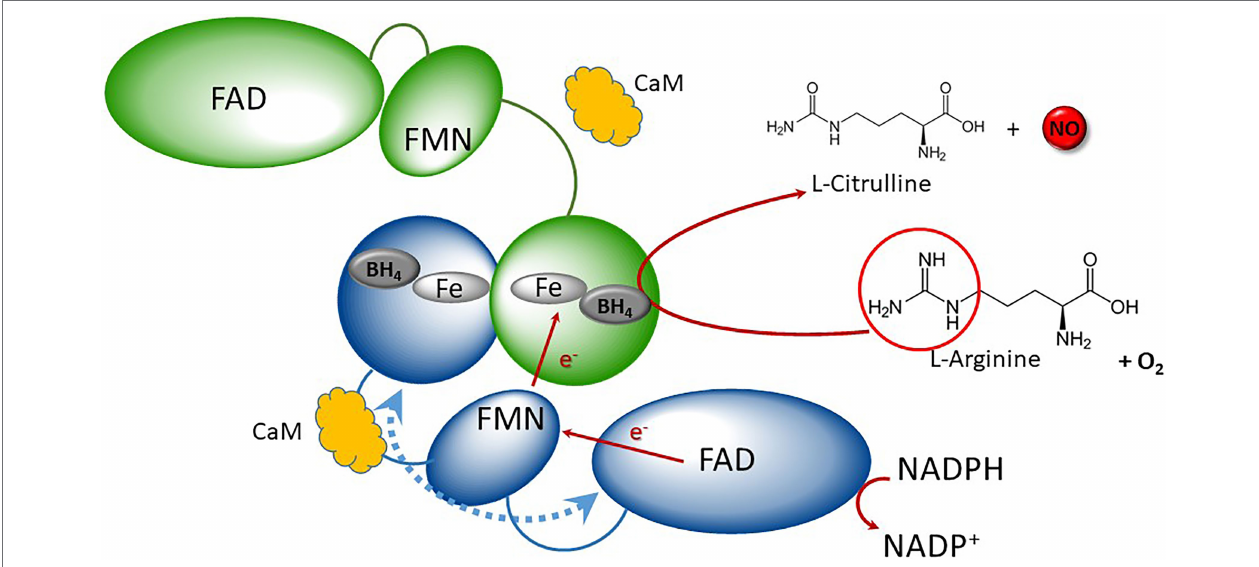
FIGURE 1 | Schematic representation of canonical NOS catalytic mechanism. Canonical NOSs display homodimeric quaternary structure (blue and green monomers). NOS monomers consist of two main domains: the N-terminal oxygenase (round-shaped) and the C-terminal reductase, containing FNR (ellipse) and flavodoxin (small ellipse). They both shelter different redox cofactors: FAD, FMN, heme, and BH4. Reductase and oxygenase domains are interconnected by a Calmodulin (CaM, orange cloud)-binding domain. Electrons are purveyed by NADPH and are shuttled to the flavodoxin via the FAD. Upon Cam binding, electron transfer then occurs from the FMN of one monomer (blue) to the heme of the second one (green), resulting to the oxidation of Arginine in presence of oxygen into Citrulline + NO. Adapted from Santolini